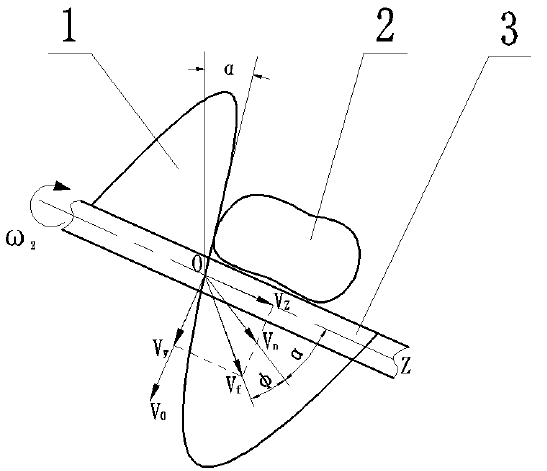
Figure 4. Analysis of axial movement process of fruit–soil mixture.1. Spiral conveyor blade; 2. Soil particle; 3. Drive shaft. ( α is the tilt angle of the fruit–soil separation device, (°); Ø is the clod and friction angle of the helical blade, (°); ω 2 is the rotational angular velocity of the fruit–soil separation unit, rad·s − 1 ; V 0 is the involved motion velocity of O point on the spiral blade, m·s − 1 ; V z is the axial velocity of the spiral blade, m·s − 1 ; V f is the absolute velocity of the material on the spiral blade, m·s − 1 ; V n is the synthesis speed of material on the spiral blade, m·s − 1 ).